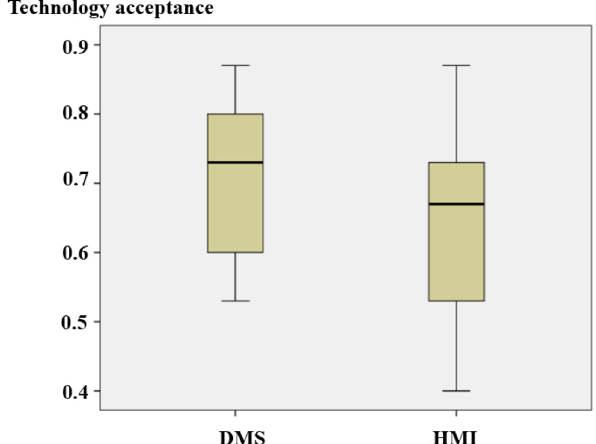
Figure 6 Acceptance of different technology types for CV-VSL